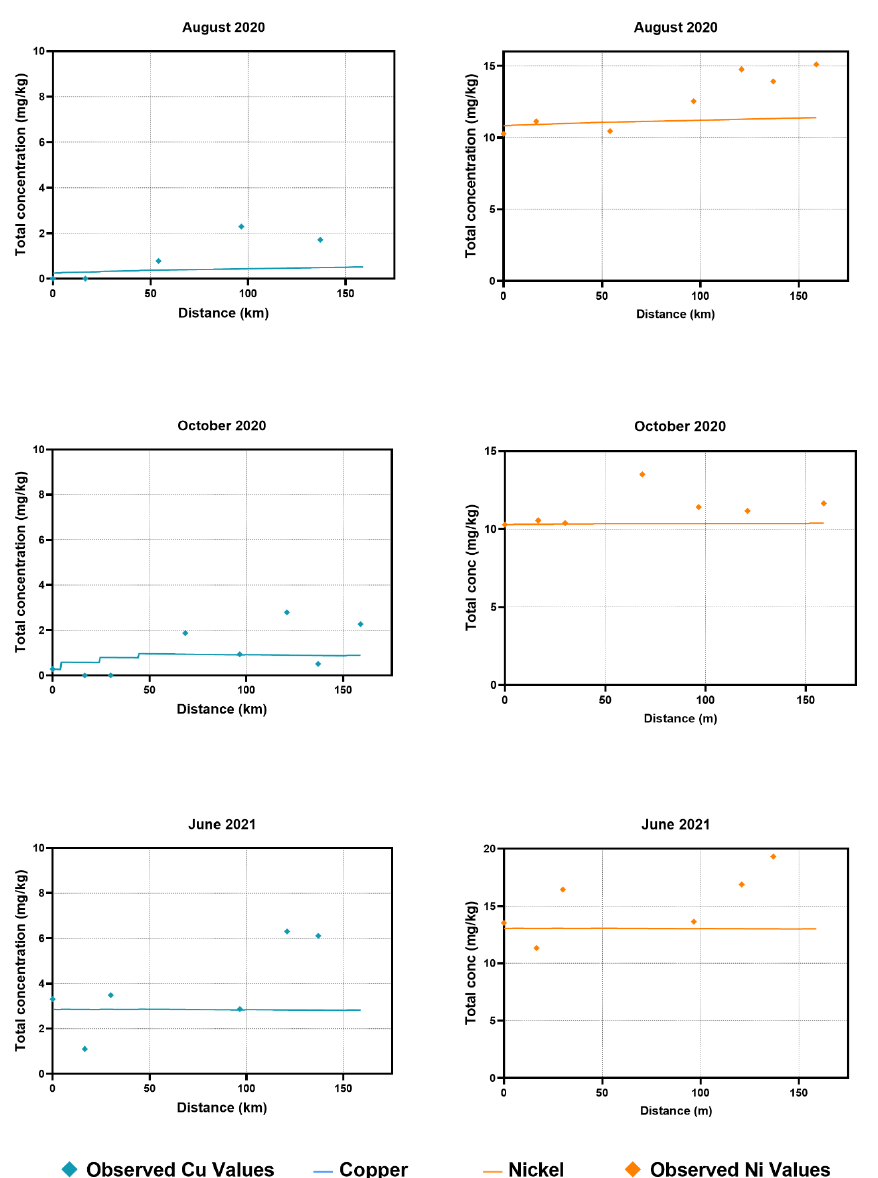
Figure 6. Longitudinal profiles of sediment concentrations for both trace metals in the 2020 and 2021 field seasons.